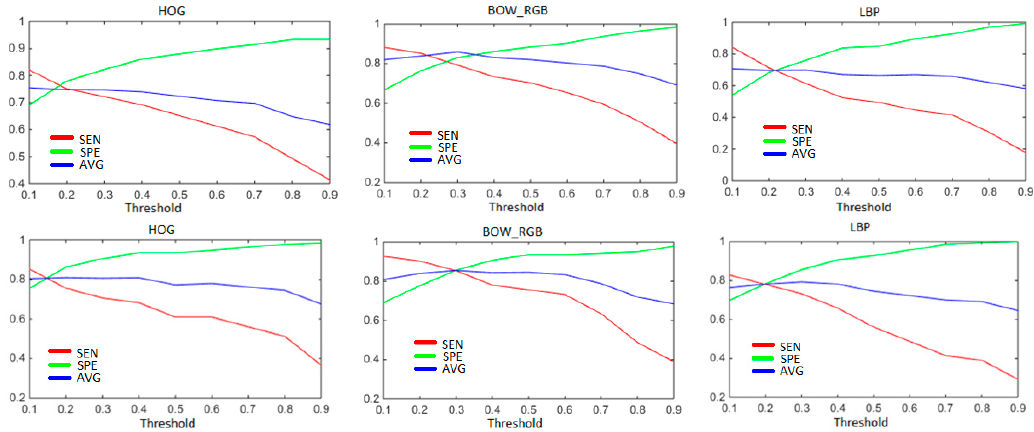
Figure 8. Impact of the threshold value on the classification rates using the three feature types. Upper row for Dataset 1, bottom row for Dataset 2.